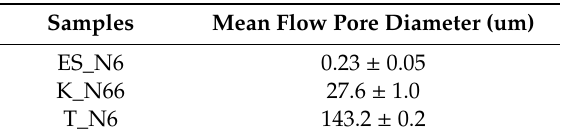
Figure 2. Pore size distribution and mean flow pore size of: ( A ) nylon 6 nanofibers (ES_N6); ( B ) nylon 66 knit (K_N66); ( C ) nylon 6 tricot (T-N6); ( D ) comparison of the mean flow pore size of ES_N6, K_N66, and T_N6. Table 1. Mean flow pore size of polyamide fabrics.